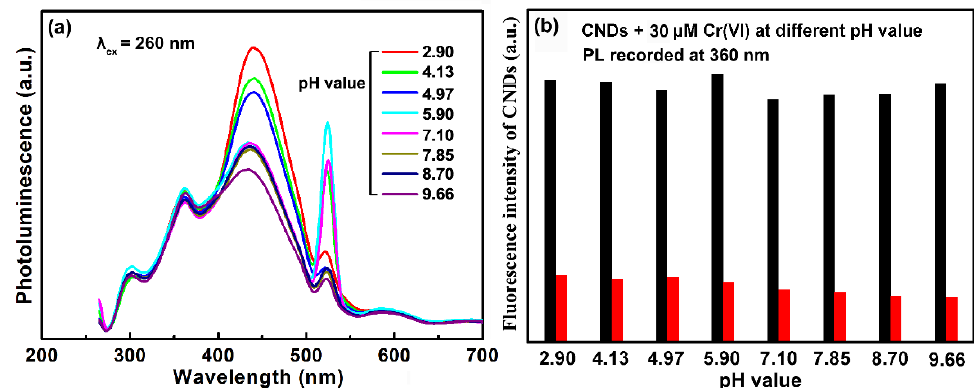
Figure 9. ( a ) PL spectra of the CNDs in different pH values. The excitation wavelength was 260 nm. ( b ) Effects of pH values on the fluorescent quenching of the CNDs by 30 μM Cr(VI).